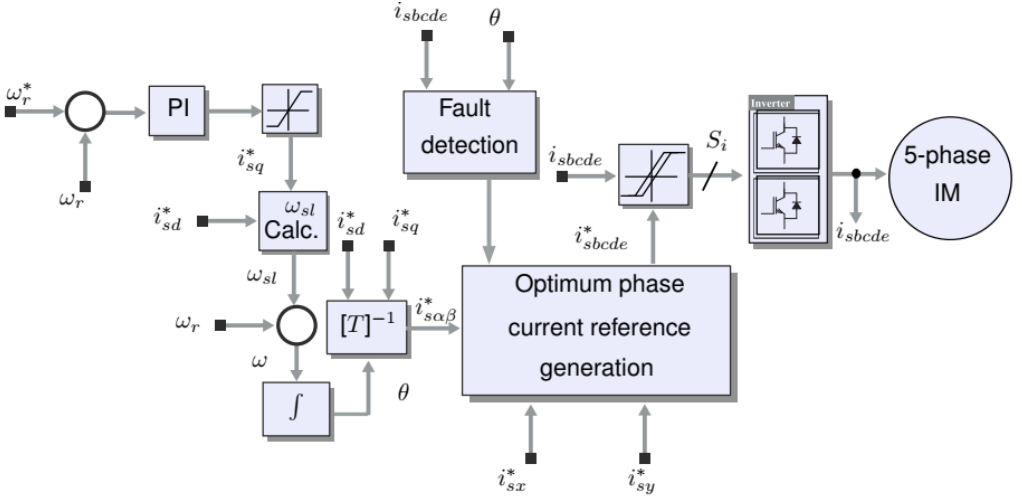
Figure 3. Hysteresis controller ’ s structure for post-fault operation.